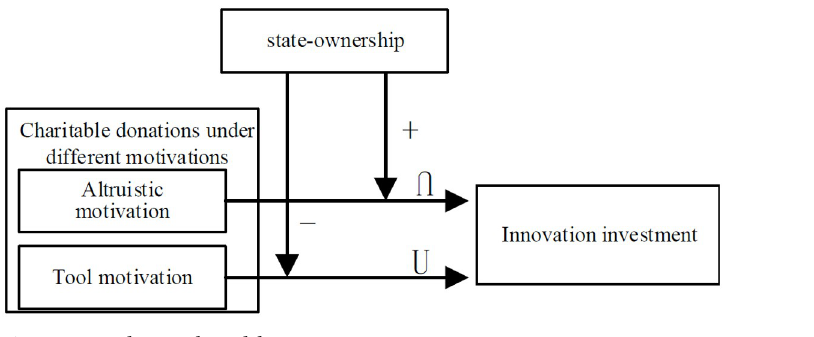
Fig 4. Proposed research